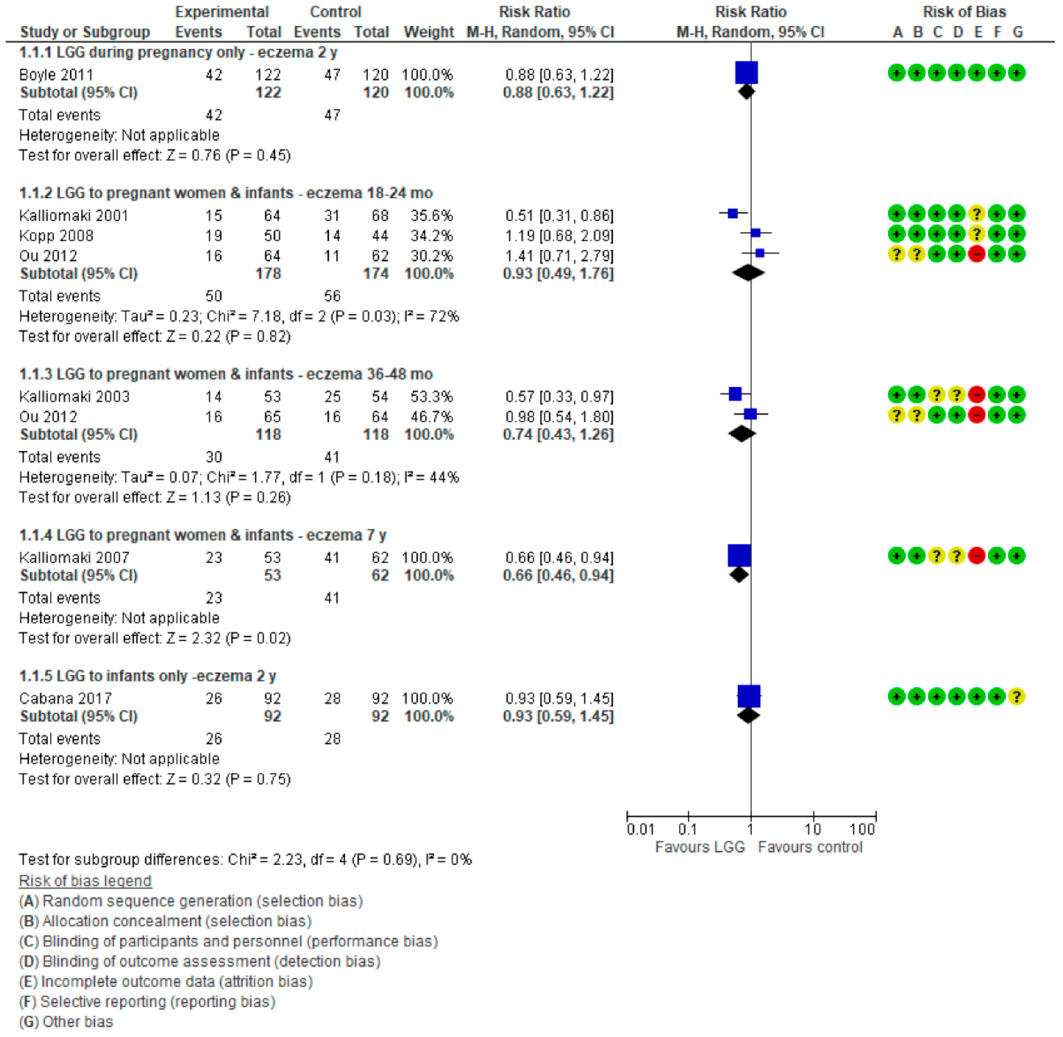
Figure 3. Primary outcome: Effect of LGG supplementation on eczema (data presented based on the timing of LGG administration and the timing of assessment).